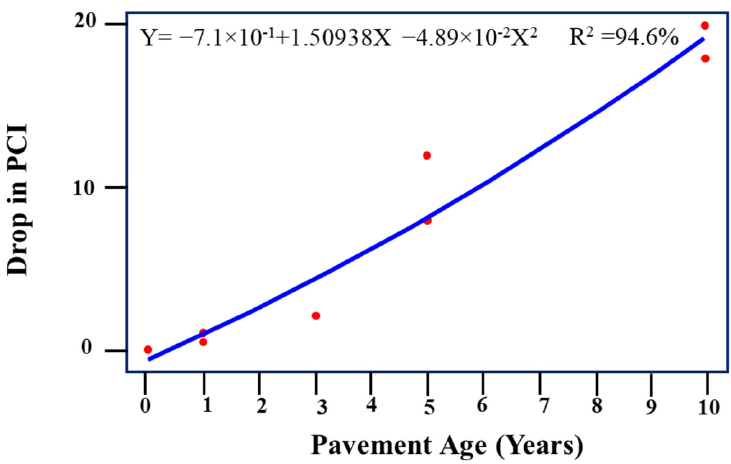
Figure 9. Effect of the overlay on the deterioration of PCI for low traffic.